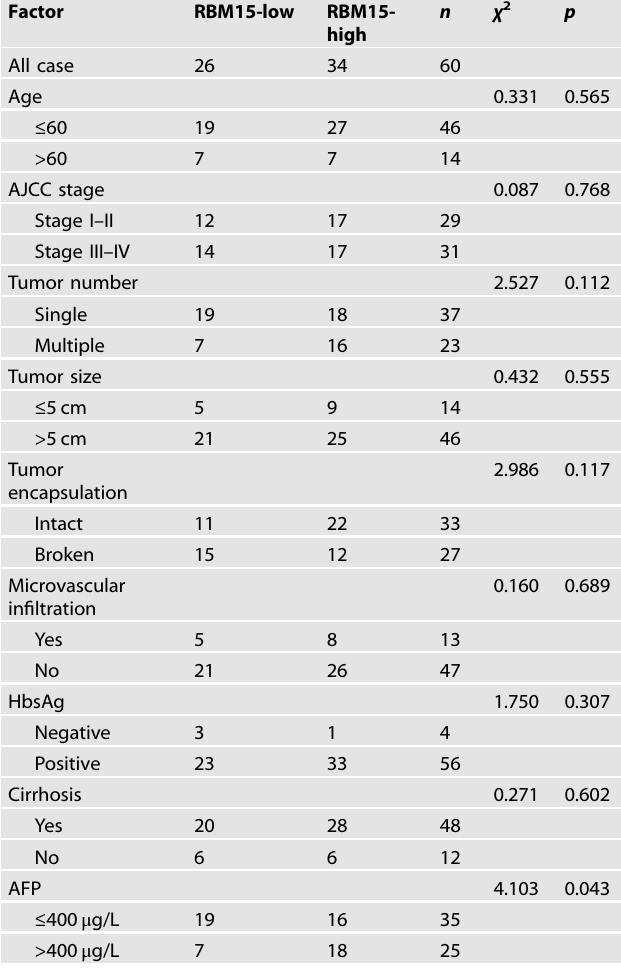
Table 1. Clinical characteristics of cohort-1 depending on the RBM15 expression